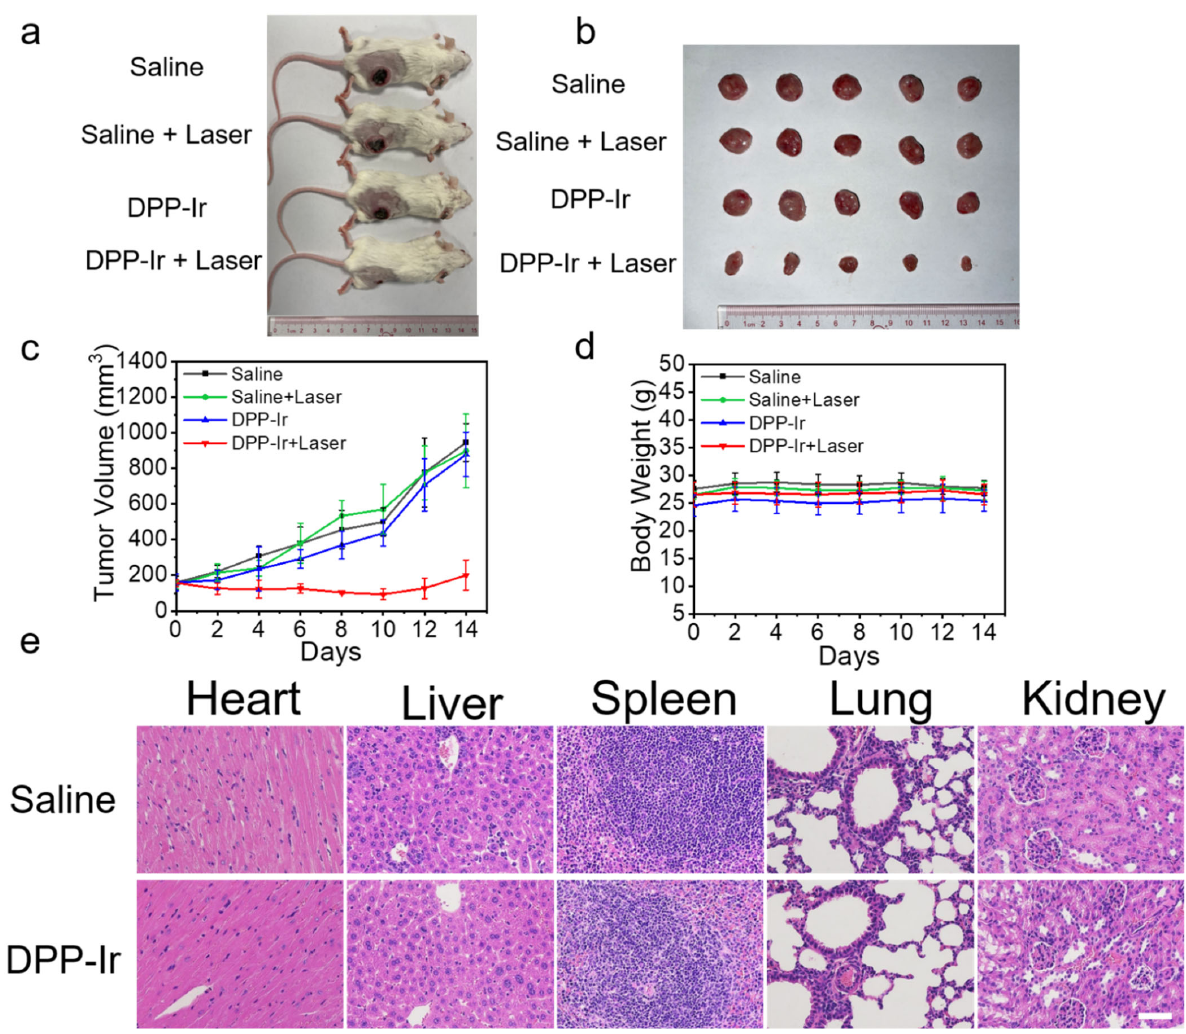
Figure 5. ( a ) Representative photographs of 4T1 tumor-bearing mice after different treatments. ( b ) Corresponding tumor images of each group after 14 days of treatment. ( c ) Time-dependent tumor growth curves ( n = 5) observed after different treatments. ( d ) Body weight measurements of mice after various treatments. ( e ) H&E-stained slices of the heart, liver, spleen, lung, and kidney of healthy mice and mice treated with DPP ‐ Ir nanoparticles. Scale bar: 50 μ m.